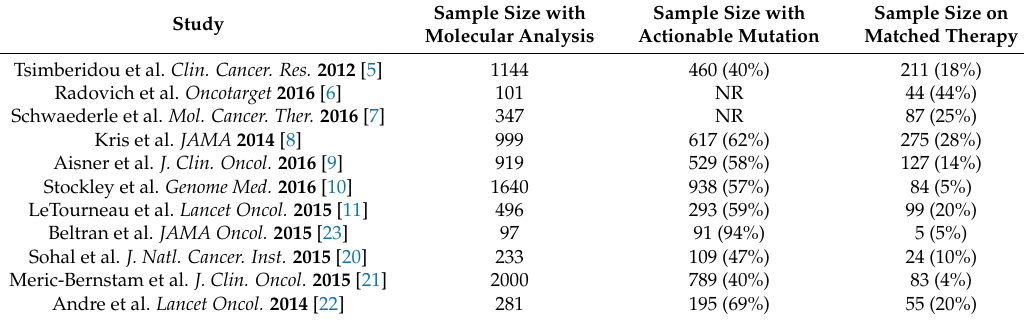
Table 2. The Percentage of Patients Receiving Matched Therapy. Summary of the number of patients with sequencing data, the number of patients with an actionable mutation, and the number of patients who go on to receive therapy matched to their sequencing results. Sample Size with Sample Size with Sample Size on Study Molecular Analysis Actionable Mutation Matched Therapy Tsimberidou et al. Clin. Cancer. Res. 2012